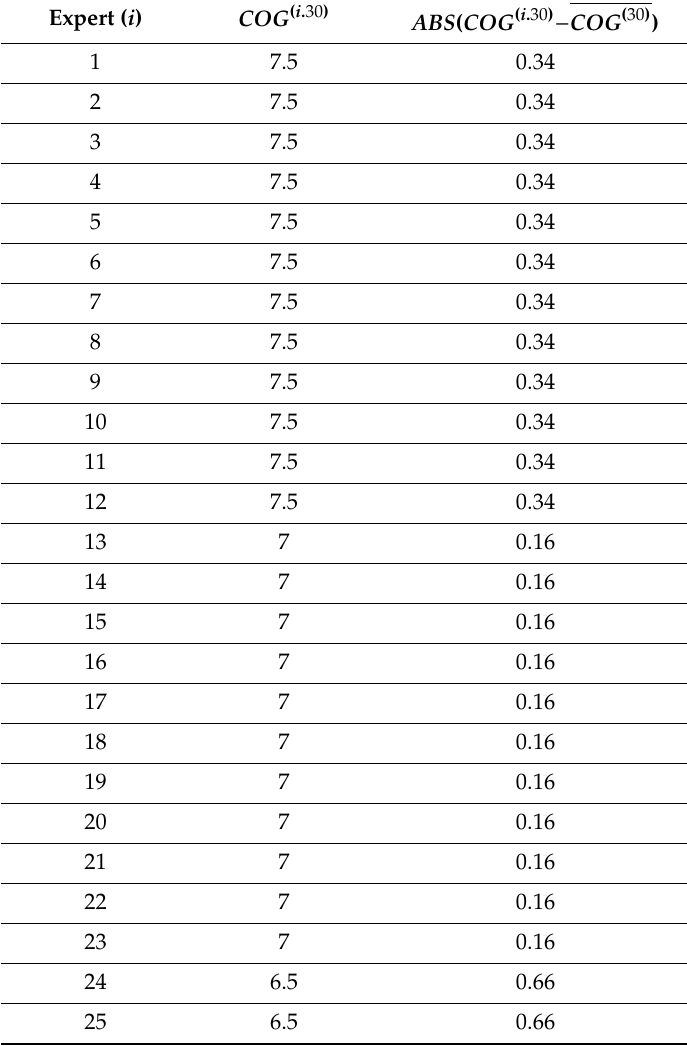
Table 5. Checking consensus